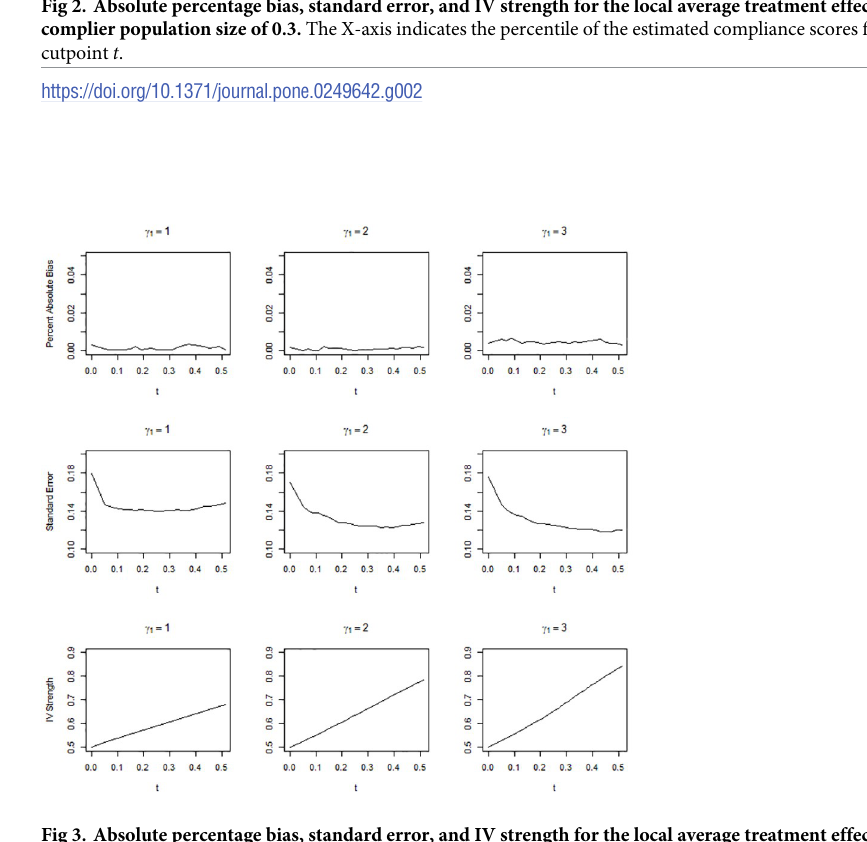
Fig 3. Absolute percentage bias, standard error, and IV strength for the local average treatment effect with a complier population size of 0.5. The X-axis indicates the percentile of the estimated compliance scores for the cutpoint t .